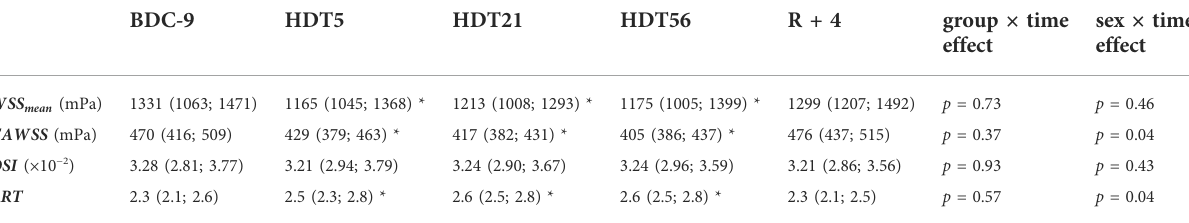
TABLE 4 Evolution of wall shear stress results computed in the ascending aorta (plane 2, Figure 2) all over the study. Data are presented as median ( fi rstquartile;thirdquartile).Thegroup×timeandsex×timeeffectsaredisplayedinthelastcolumns. WSS mean :averageamplitudeofallthe WSS reference points during the peak systolic phase, TAWSS : time-averaged wall shear stress, OSI : oscillatory shear index, RRT : relative residence time, BDC:baselinedatacollection,HDT:head-downtilt,R:recovery.*:Signi fi cantdifferencewithBDC-9usingthetwo-stagelinearstep-upprocedureof Benjamini, Krieger, and Yekuteli with a false discovery rate set at 0.05.